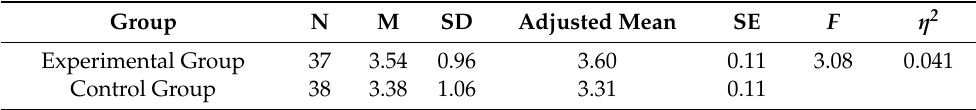
Table 3. The ANCOVA analysis data of self-efficacy.